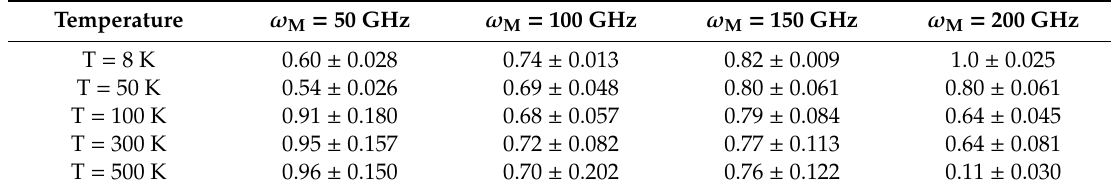
Table 1. Statistical results of R Tran of the zigzag model and subjected to M r = 0 eV.